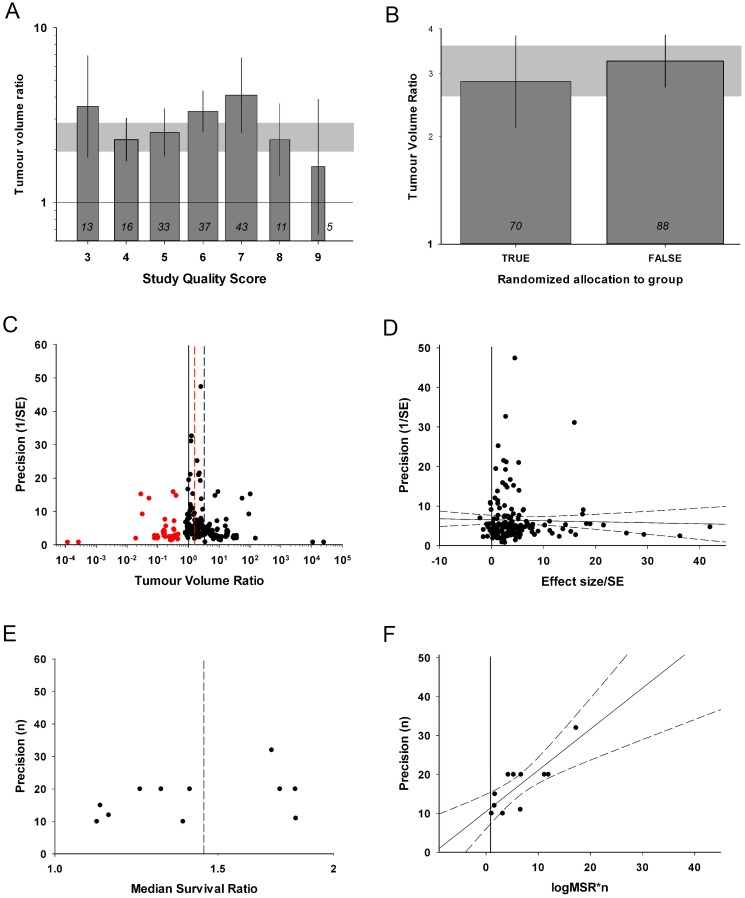
Evaluation of study quality and publication bias.(A) Quality score is associated with between-study heterogeneity tumour volume studies, with a trend for higher quality studies to report smaller effect sizes (χ2 = 1373, df = 6, p<0.00385). (B) Randomized studies were associated with smaller tumour volume reductions than non-randomised studies (χ2 = 68.1, df = 1, p<0.00385). (C and D) Both funnel plot and Egger regression indicate a presence of publication bias in tumour volume data (t = 8.772, p<0.001). Trim and Fill analysis added 38 ‘missing’ studies, with a sizeable reduction in global efficacy estimate (red plots). (E and F) For survival studies, funnel plot does not show any obvious asymmetry, but Egger regression suggests a publication bias (t = 8.772, p<0.001). The grey bands in A and B represent global 95% confidence intervals; columns represent mean ± 95%CI and column width a measure of number of comparisons within each stratum; the number of comparisons is included at the base of each column. Dotted lines in C and E represent global estimates of efficacy before (grey) and after (red) Trim and fill analysis. Dotted lines in D and F represent 95%CI of the regression. The vertical solid lines in A, C, D and F represent the level of neutral treatment effect.